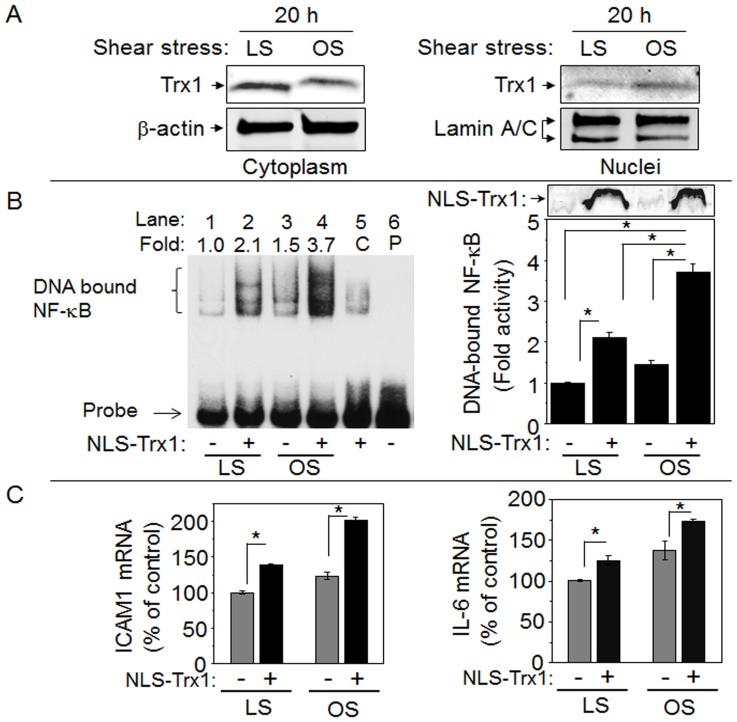
Nuclear translocation of Trx1 in response to oscillatory shear stress and stimulated NF-κB activation and proinflammatory gene expression by increased nuclear Trx1.EC exposed either LS or OS for 24 h were fractionated to obtain cytosolic and nuclear fractions. A. Cytosolic (left) and nuclear (right) fractions were examined for Trx1 expression level by Western blotting probed with an antibody specific to Trx1. To verify each compartment, cytosolic and nuclear fractions were probed with β-actin and lamin antibodies, respectively. B. EC transfected with NLS-Trx1 or VC were exposed to LS or OS for 24 h and nuclear fractions were examined for NF-κB activity by EMSA. NLS-Trx1 expression measured by Western blotting with antibody specific to Myc epitope is shown on right, top. C. Total RNA was isolated from EC exposed to LS or OS after NLS-Trx1 transfection. cDNA obtained from reverse transcription of total RNA were quantitated for ICAM1 and IL-6 genes by qRT- PCR. Data are mean ± SE (* p<0.05).